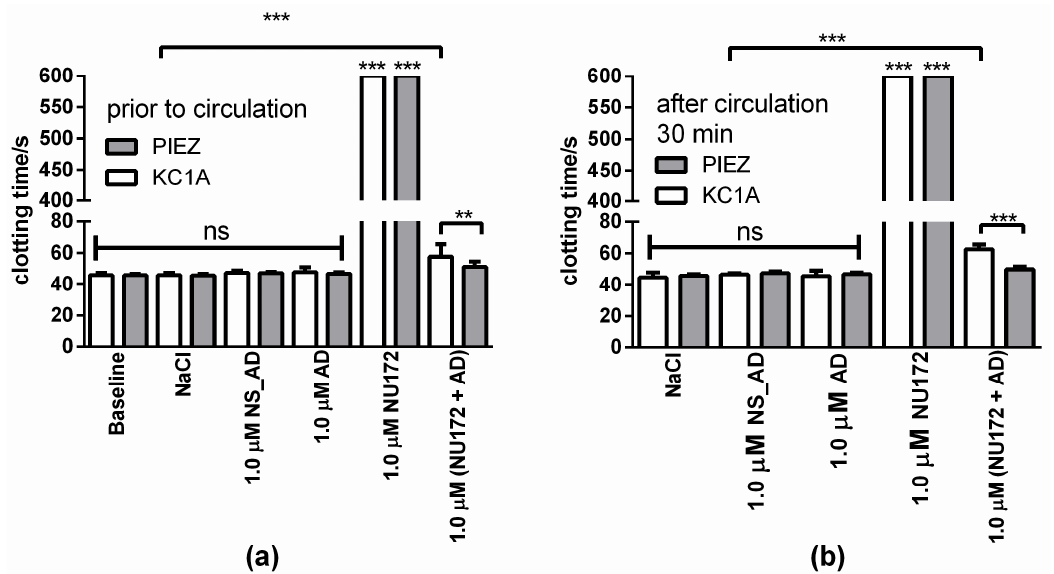
Figure 7. Detection of clotting time (CT) after the dynamic incubation of heparinized blood (1 IU/mL) containing oligonucleotides in an in vitro rotation model using PIEZ system or ball coagulometer (KC1A). Heparinized blood was incubated for 2 min with 1.0 µM NU172, then 1.0 µM AD was added to the NU172 aptamer containing blood and incubated for 5 min. The CT was determined ( a ) before and ( b ) after the circulation for 30 min at 37 °C in an in vitro rotation model. Blood without any addition was indicated as a baseline. Blood with NaCl, 1.0 µM NS_AD, or AD was used as a negative control. Blood with 1.0 µM NU172 served as a positive control. Blood from five different volunteers was used (n = 5 ± SD). The statistical analysis was performed using two-way ANOVA (** p < 0.01, *** p < 0.001, ns: not significant).